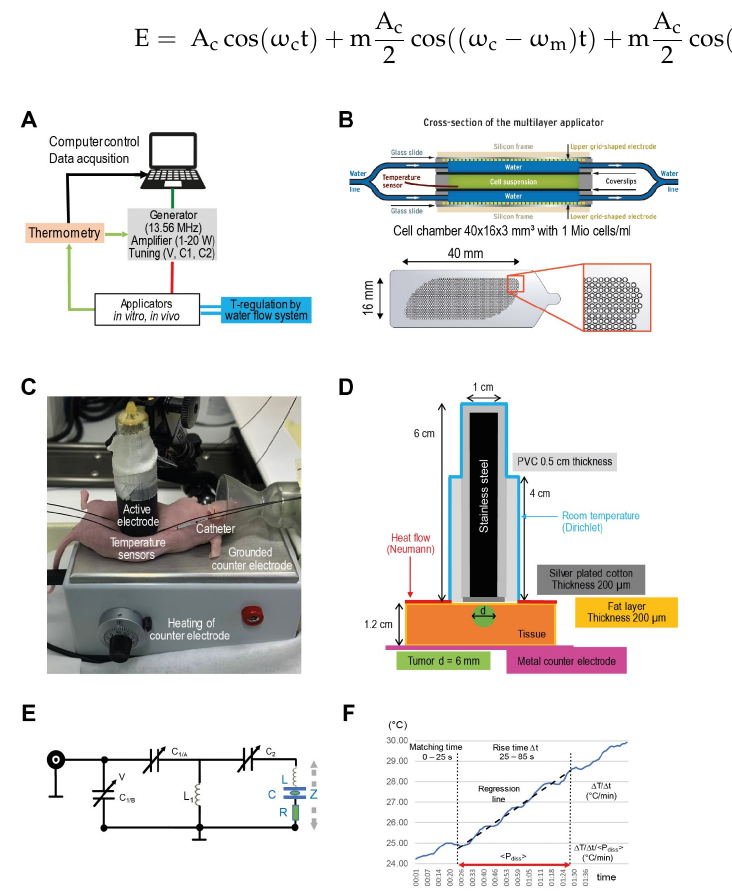
Figure 1. ( A ) Experimental system. Schematic of LabEHY-200 system for preclinical in vitro and in vivo studies. With reference to the clinical system EHY-2000+ [8], we initially set the AM-spectrum to 100/f (f ≥ 100 Hz). ( B ) In vitro applicator. Schematic cross-section of the in vitro applicator, which is suitable to adjust the power density (via P adj ) and temperature (via water flow system) separately. The grid-shaped electrodes (below) enabled enlargement of the cell chamber volume (green) up to ~2 mL. ( C ) In vivo applicator. Components of the in vivo applicator in situ as positioned upon an implanted HT29 tumor in a nude mouse. ( D ) Model of in vivo applicator. The exposed volume